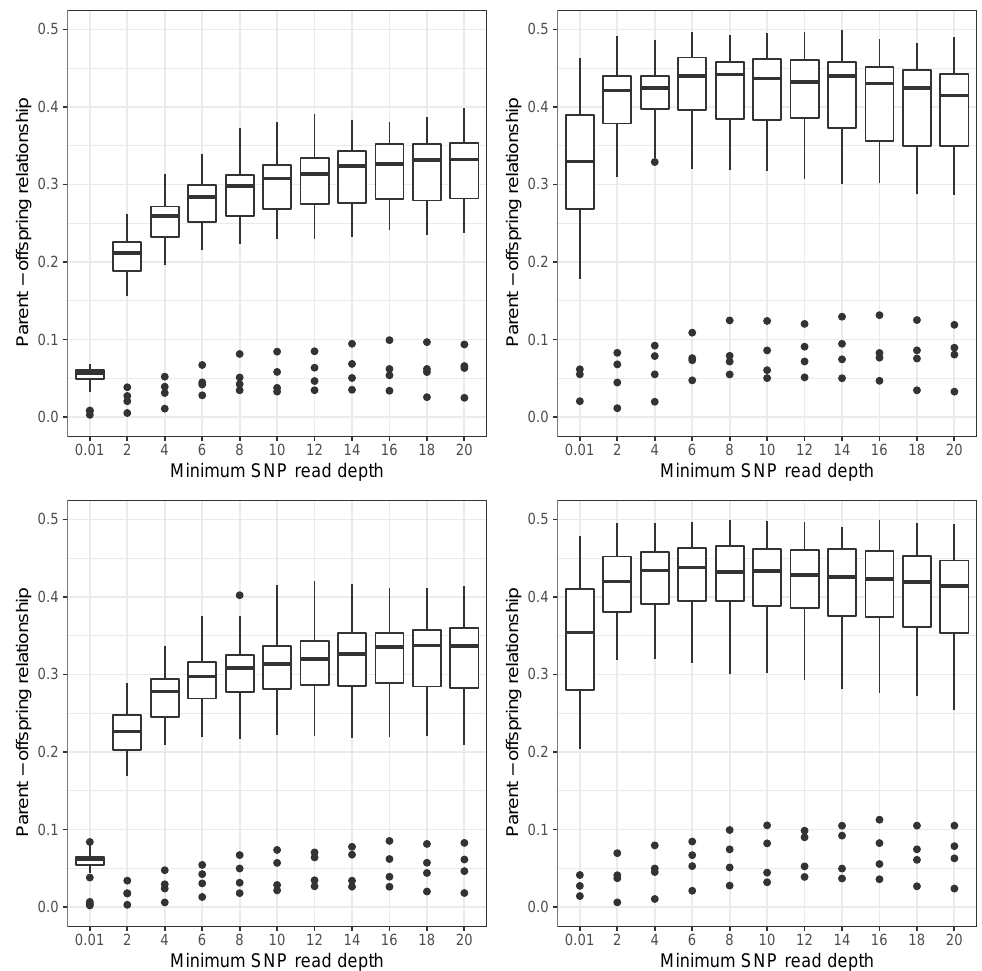
Figure 4. Parent-offspring relatedness distribution. Distribution of estimated relatedness for parent- offspring pairs under different minimum SNP read depth thresholds in the whole population ( upper plots ) and only E.nitens population ( bottom plots ) using G1 [42] ( left plots ) and G5 [59] ( right plots ) relationship